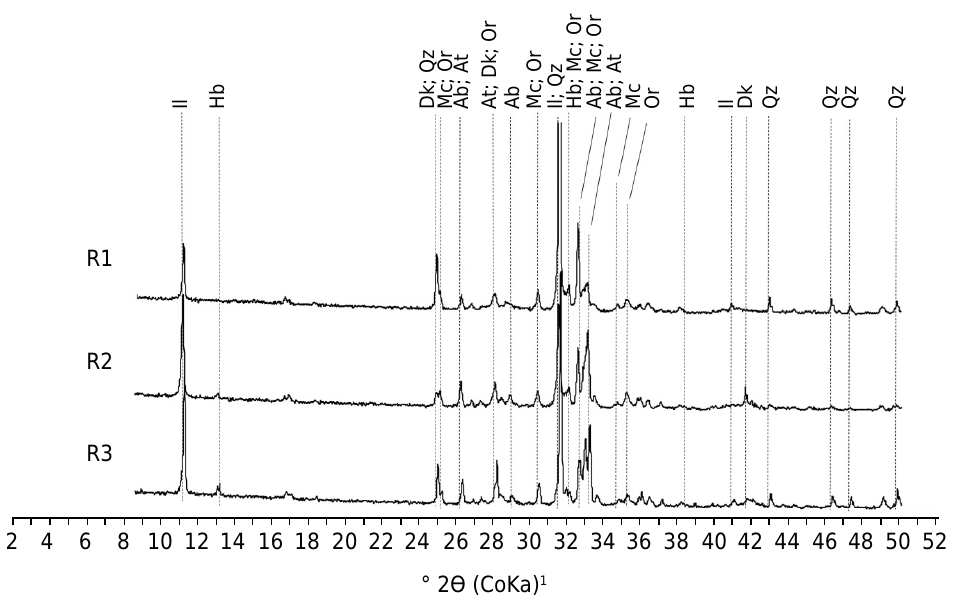
Figure 1. X ray diffraction, chemical composition, interplanar distance and minerals composing the rock residues (R1, R2 and R3). Quartz (Qz), Illite (II), Hornblende (Hb), Dickite (Dk), Anorthite (At), Microcline (Mc), Orthoclase (Or), Albite